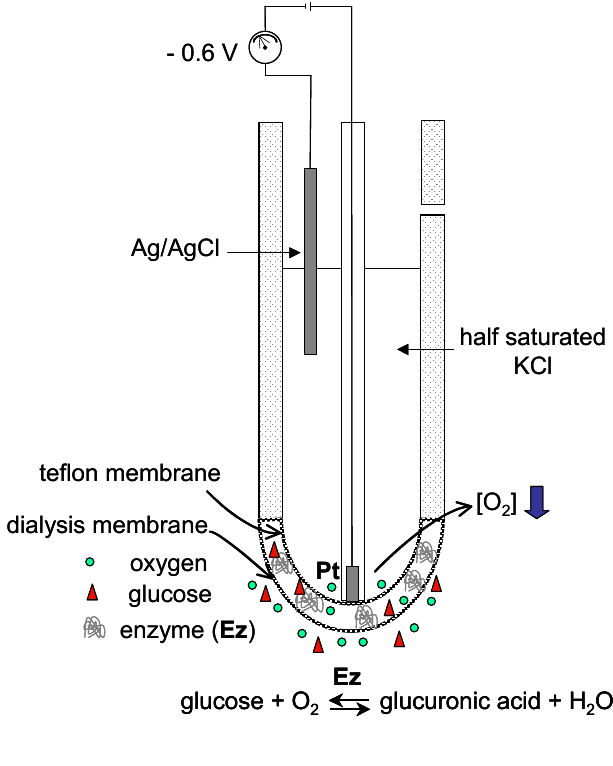
Figure 3 . Illustration of Clark’s enzyme electrode displaying the reactions occurring at the inner solution containing the enzyme and at the electrode surface.2. Selectivity-